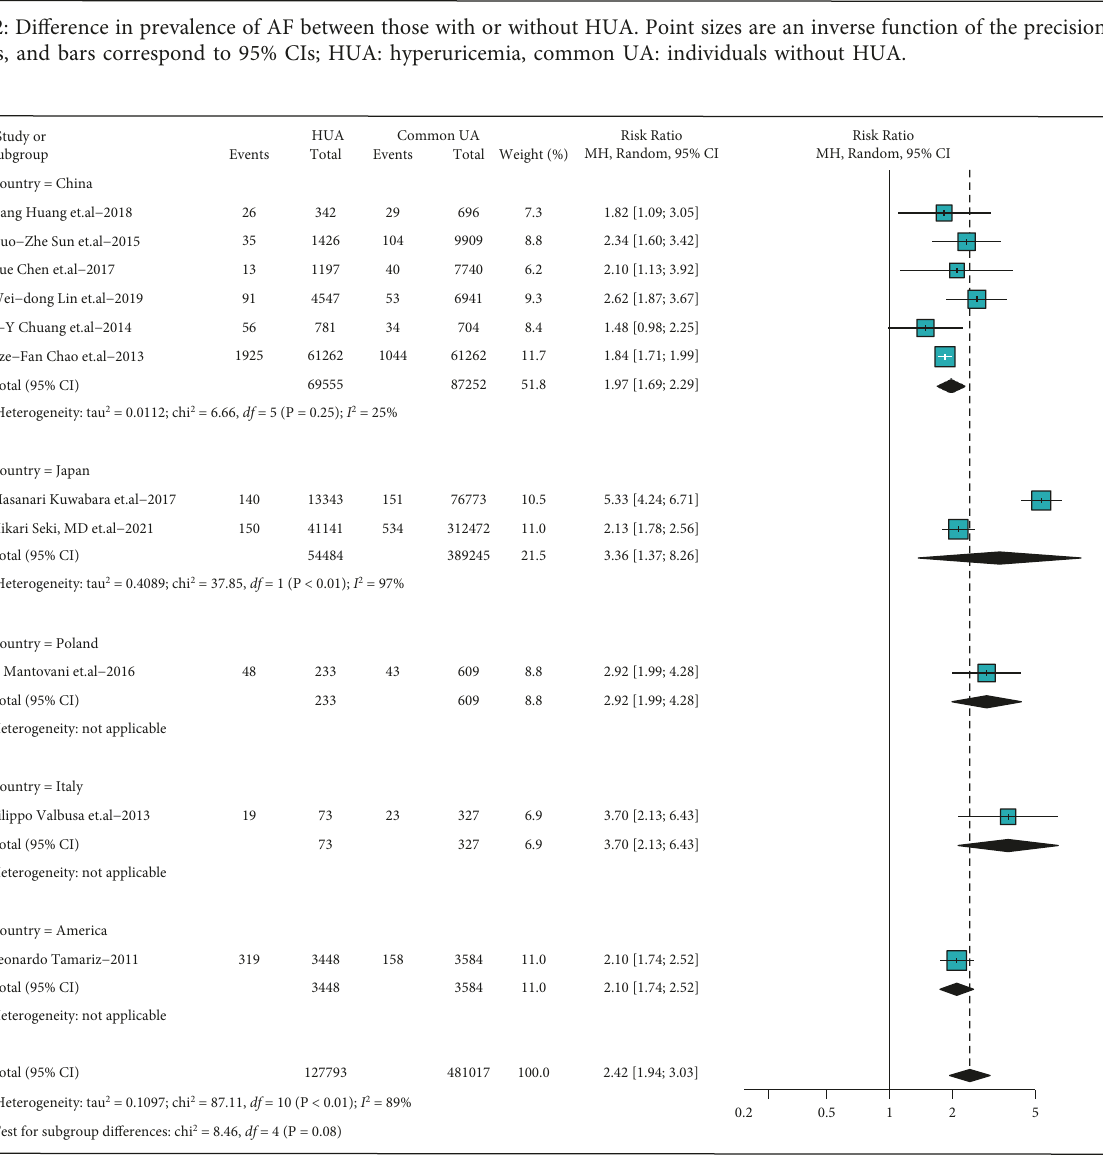
Figure 3: Associations between AF and HUA in different countries. Point sizes are an inverse function of the precision of the estimates, and bars correspond to 95% CIs; HUA: hyperuricemia, common UA: individuals without